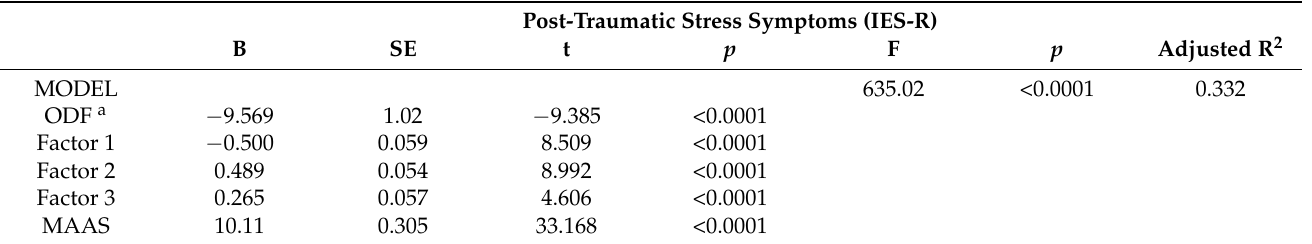
Table 4. Multivariate linear regressions for mindfulness and defense mechanisms predicting post- traumatic stress symptoms (N =